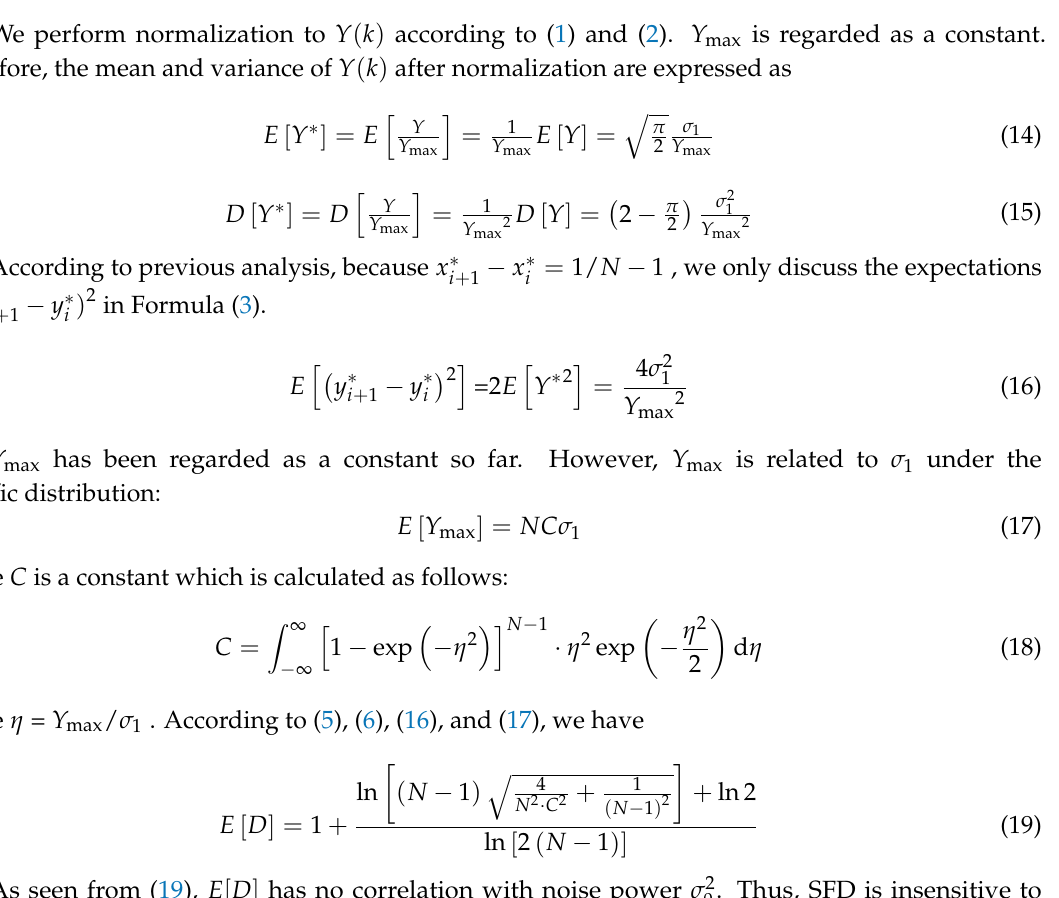
Figure 2 calculates the SFD of white Gaussian noise versus different power. Sequence length N = 4000. From the figure, the mean change range of Gaussian white noise SFD is smaller, which always fluctuates near 1.811 when noise power changes within the range − 30–20,dBm. Simulation results validate that the noise SFD values have no correlation with noise power, which means that SFD can overcome the influence of noise uncertainty to a certain extent.